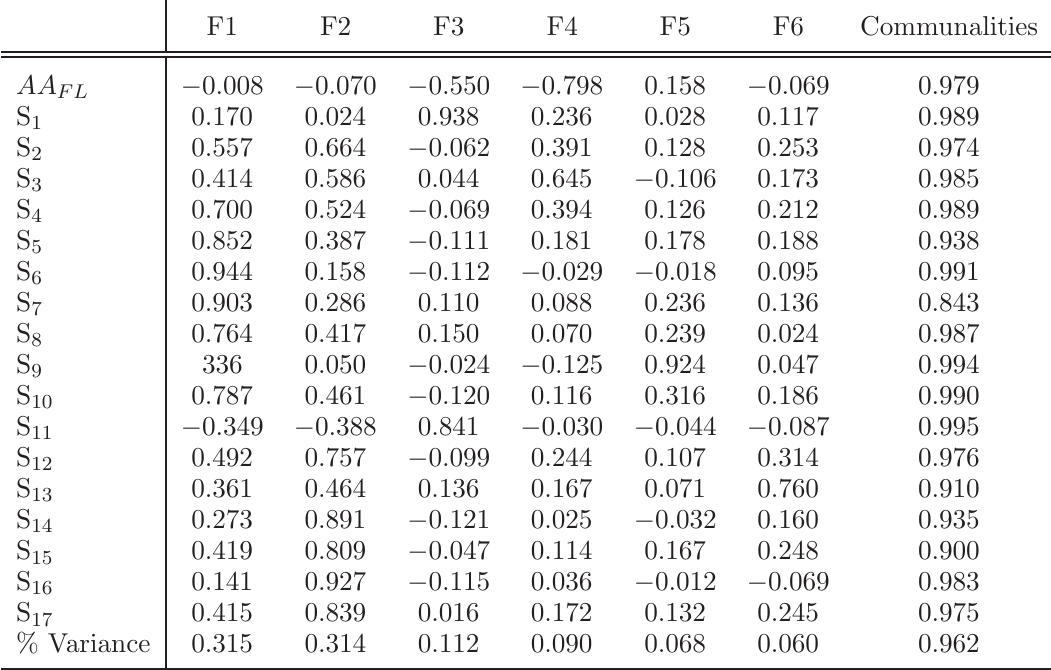
Table 4 Factor loading of the variables (antioxidant activity ( AA FL ) and predictor vari- ables) after VARIMAX